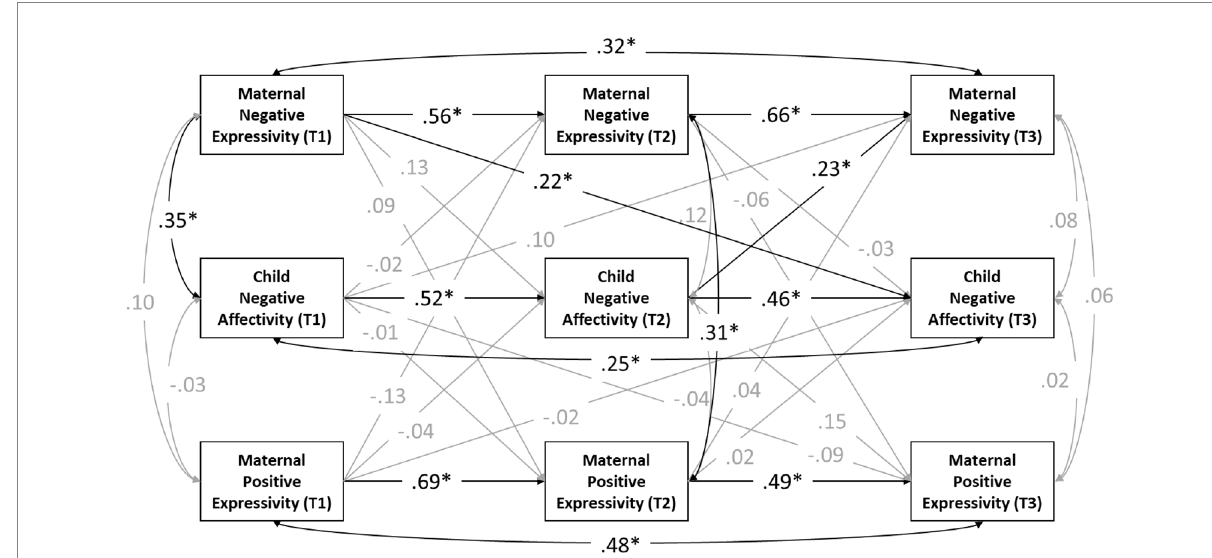
FIGURE 1 Reciprocal relations among child negative affectivity and maternal positive and negative expressivity within the family. Standardized coefficients are presented. Black lines represent significant paths, with gray lines representing non-significant paths. Mothers’ age and education were controlled for in the model and for ease of presentation, the paths are not presented. * p <